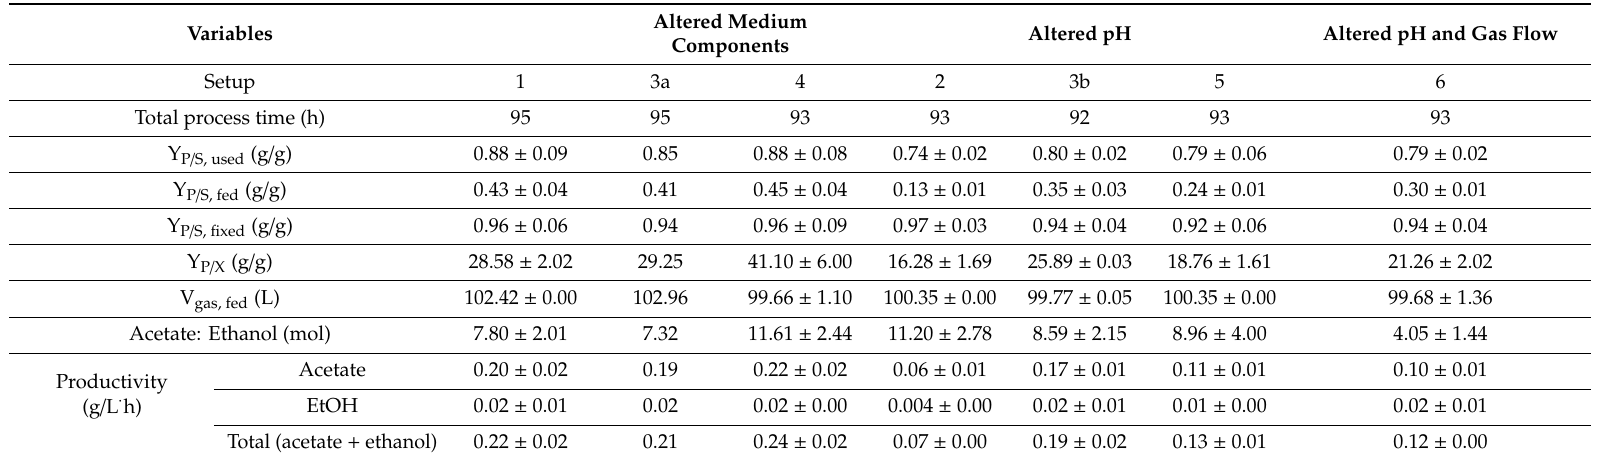
Table 3. Fermentation outcomes, yields and productivities at the endpoint. Setup 3a refers to the fermenter where pH was not altered and Setup 3b refers to the pair of fermenters where the pH was changed after 68 h to 5.4. Y P / S, (g / g) = gram of products (acetate and ethanol) formed per gram of substrate. Y P / X (g / g) = gram of product (acetate and ethanol) per gram of biomass (cell dry weight). Values are given as the average of a triplicate ( n = 3) with standard deviations, except for Setup 3a, where only the values for the fermenter left unaltered at pH 5.9 are shown, and Setup 3b, where the average of the two fermenters on which pH was modified is